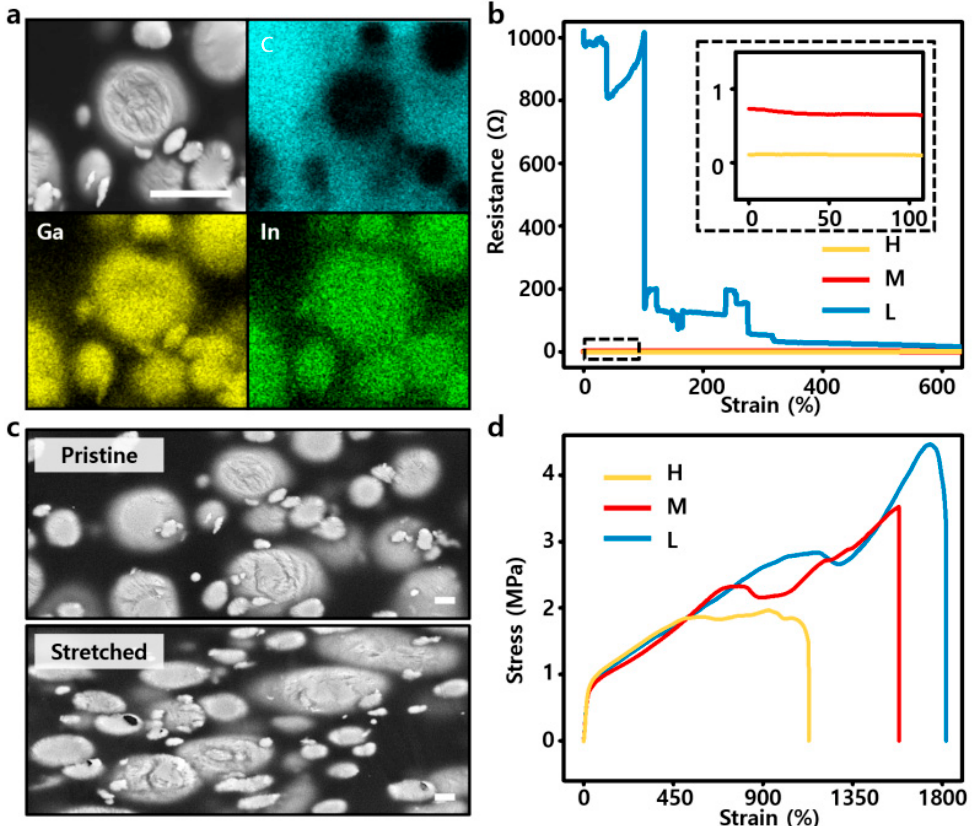
Figure 2. ( a ) SEM and corresponding EDS images of the EGaIn-SEBS composite (scale bar: 5 μ m). ( b ) Resistance–strain characteristics of EGaIn-SEBS composites having three conditions according to weight ratios (H, M, and L (meaning high, middle, and low weight ratio of EGaIn in the compo- site)). ( c ) SEM images of the EGaIn-SEBS composite before being stretched (top) and after being stretched (bottom) (scale bar: 1 μ m). ( d ) Stress–strain curves of the EGaIn-SEBS composites having three conditions according to weight ratios (H, M, and L).